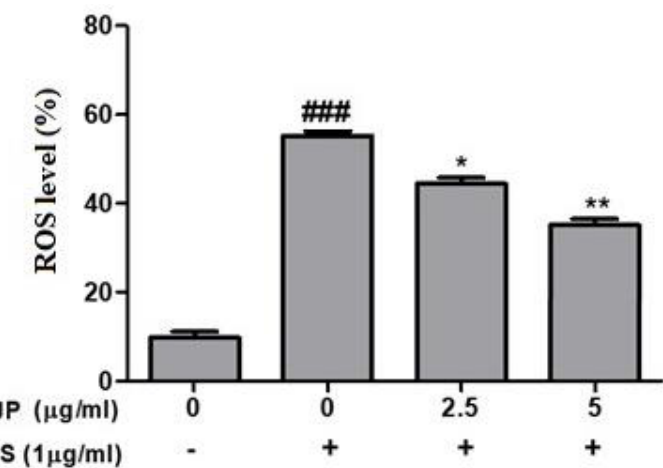
Figure 7. Effect of Citrus unshiu peel (CUP) flavonoids on reactive oxygen species (ROS) production in LPS-stimulated RAW264.7 cells. Cells treated with different concentrations of CUP (0, 2.5, and 5 μg /mL) for 24 h, with or without 1 h pre-incubation of lipopolysaccharide (LPS) (1 µg/mL), Note: Data are the mean ± SEM of experiments in triplicate (n = 3). ### p < 0.001 vs. untreated group; * p < 0.05 and ** p < 0.01 vs. LPS-alone treated group.